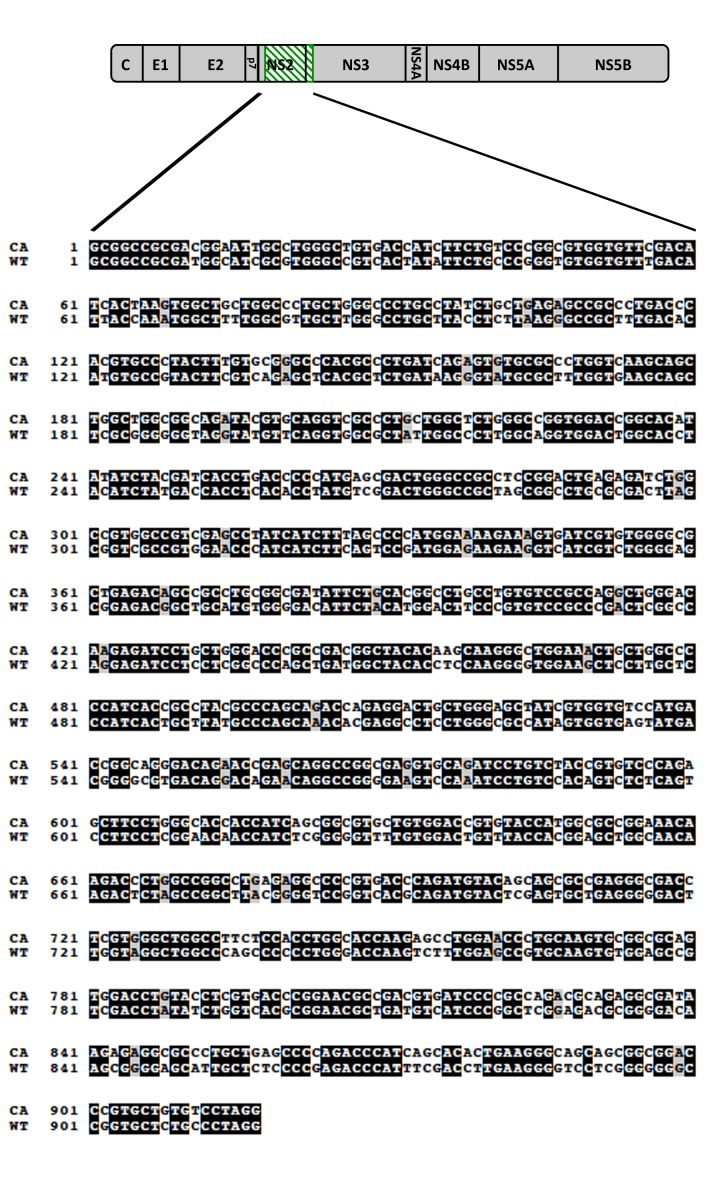
Alignment of codon-altered and wild-type JFH1 viral RNAs.Sequence alignments were generated using ClustalW to highlight the nucleotide changes incorporated into the CA-3 viral RNA. No regions of covarying mutations were observed within this region.